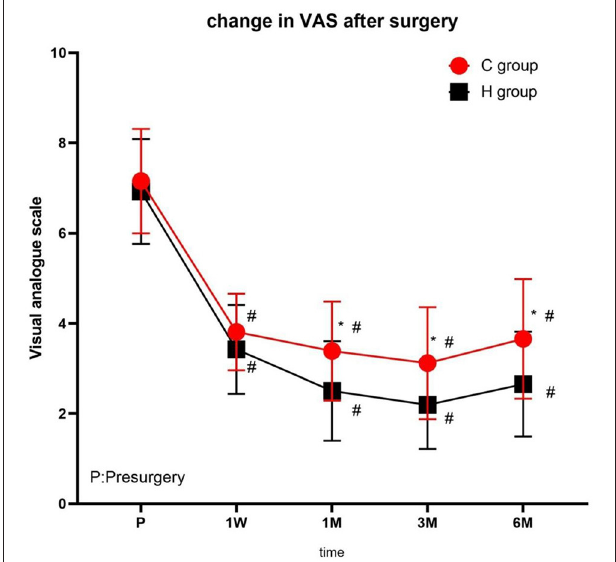
FIGURE 3 | The comparison of VAS scores preoperative and postoperative in two groups. Results are represented as mean ± SD. #Compared to preoperative, P < 0.05; *Compared with C group, P < 0.05.